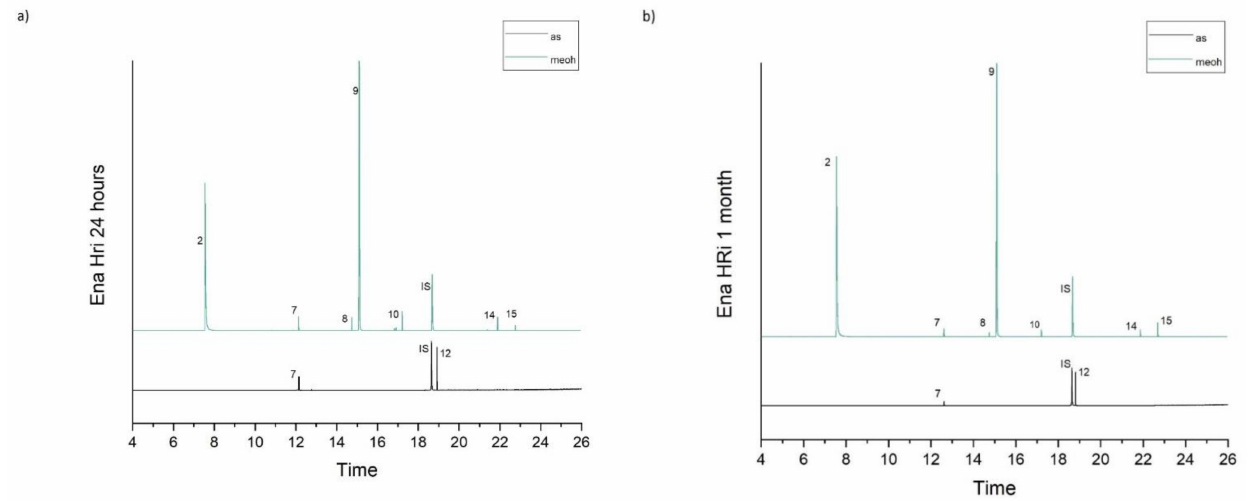
Figure 2. ( a , b ). Chromatograms of Ena HRi in artificial saliva and methanol for both observation periods (24 h and 1